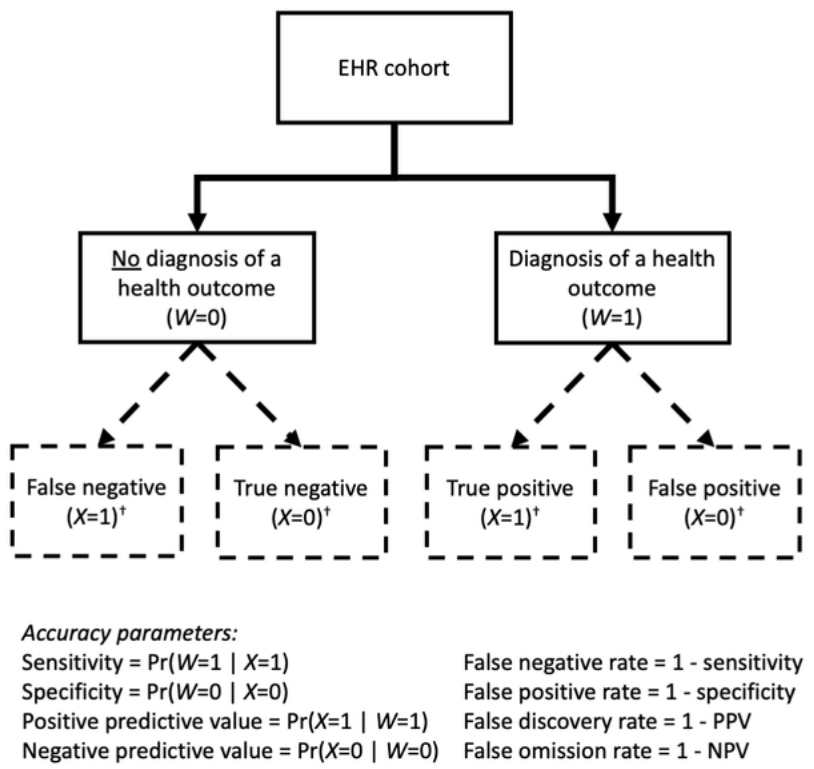
Figure 1 . Diagnosis of a health outcome in the electronic health record and its relation to the truth. ‘ X ’ denotes a patient’s true health outcome while ‘ W ’ denotes a (potentially incorrect) diagnostic code in the electronic health record . EHR = electronic health record; PPV = positive predictive value; NPV = negative predictive